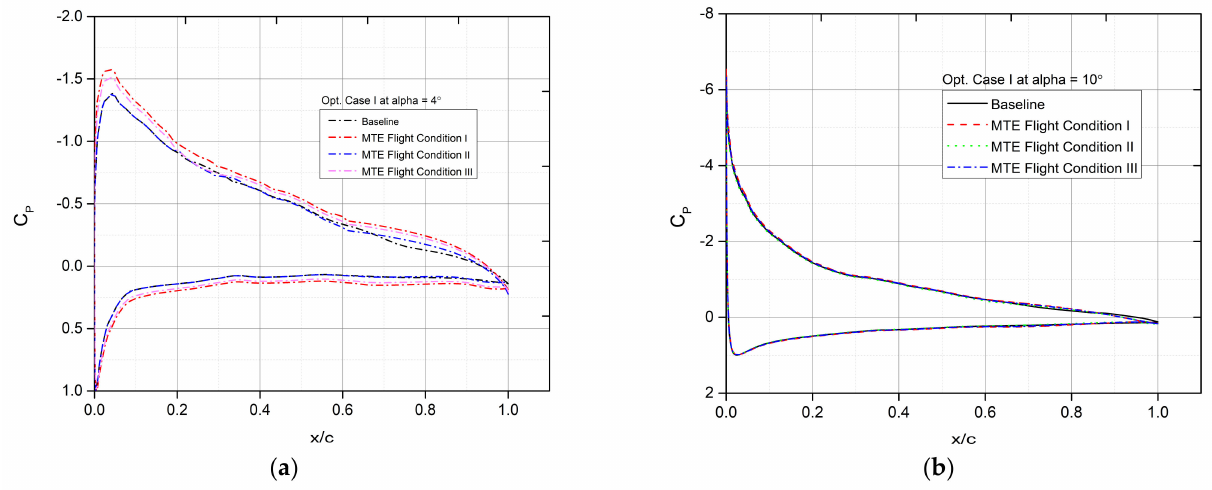
Figure 22. Pressure coefficients for different MTE design configurations. ( a ) at angles of attack of 4 ◦ ; ( b ) at angles of attack of 10 ◦